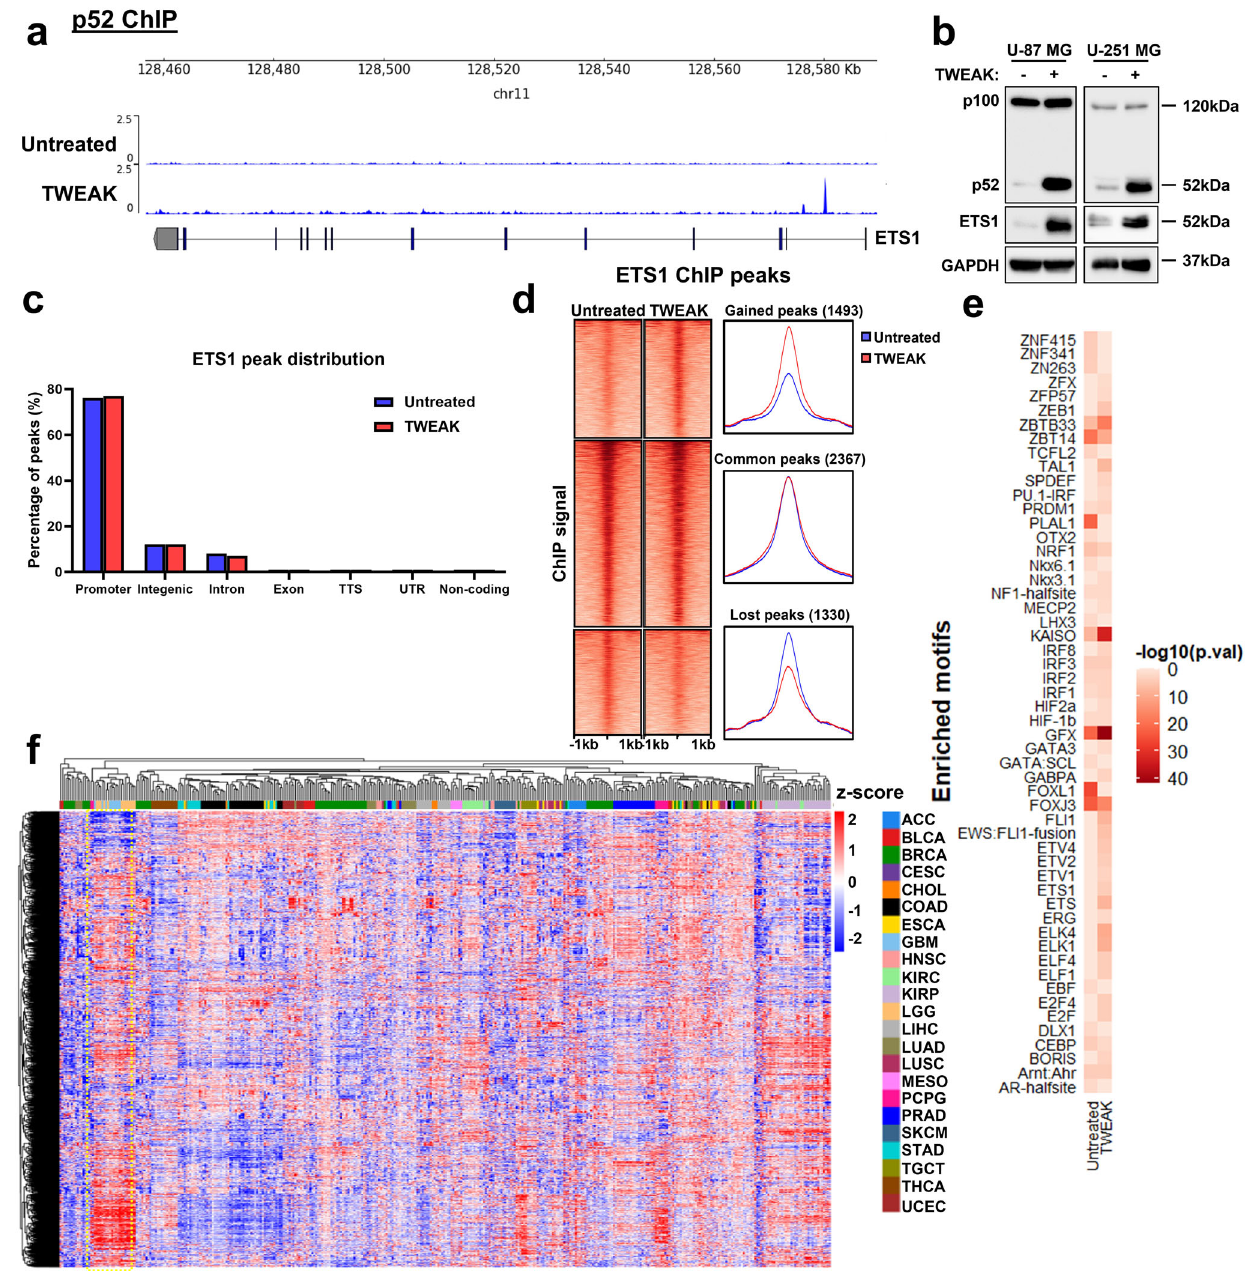
Fig. 1 p52 activation remodels ETS1 DNA binding dynamics in glioma cells. a Genome browser view of ETS1 gene locus and p52 ChIP-seq tracks in untreated and TWEAK-treated U-87 MG cells. Following TWEAK activation, p52 binds to the ETS1 promoter. b ETS1 protein expression analysed by western blotting when NF- κ B/p52 is activated via TWEAK exposure in glioma cell lines. c Genomic distribution of ETS1 DNA binding peaks in untreated and TWEAK-treated U-87 MG cells. d DNA binding dynamics of ETS1 in untreated and TWEAK-treated U-87 MG cells. Signal intensity across each region (±1 kb) is represented as a heatmap, and the average log2 fold change in signal of gained, lost or common ETS1 peaks following TWEAK treatment is displayed at the right. e Heatmap representation of the enriched ETS1 motifs in U-87 MG cells with and without TWEAK-induced NF- κ B/p52